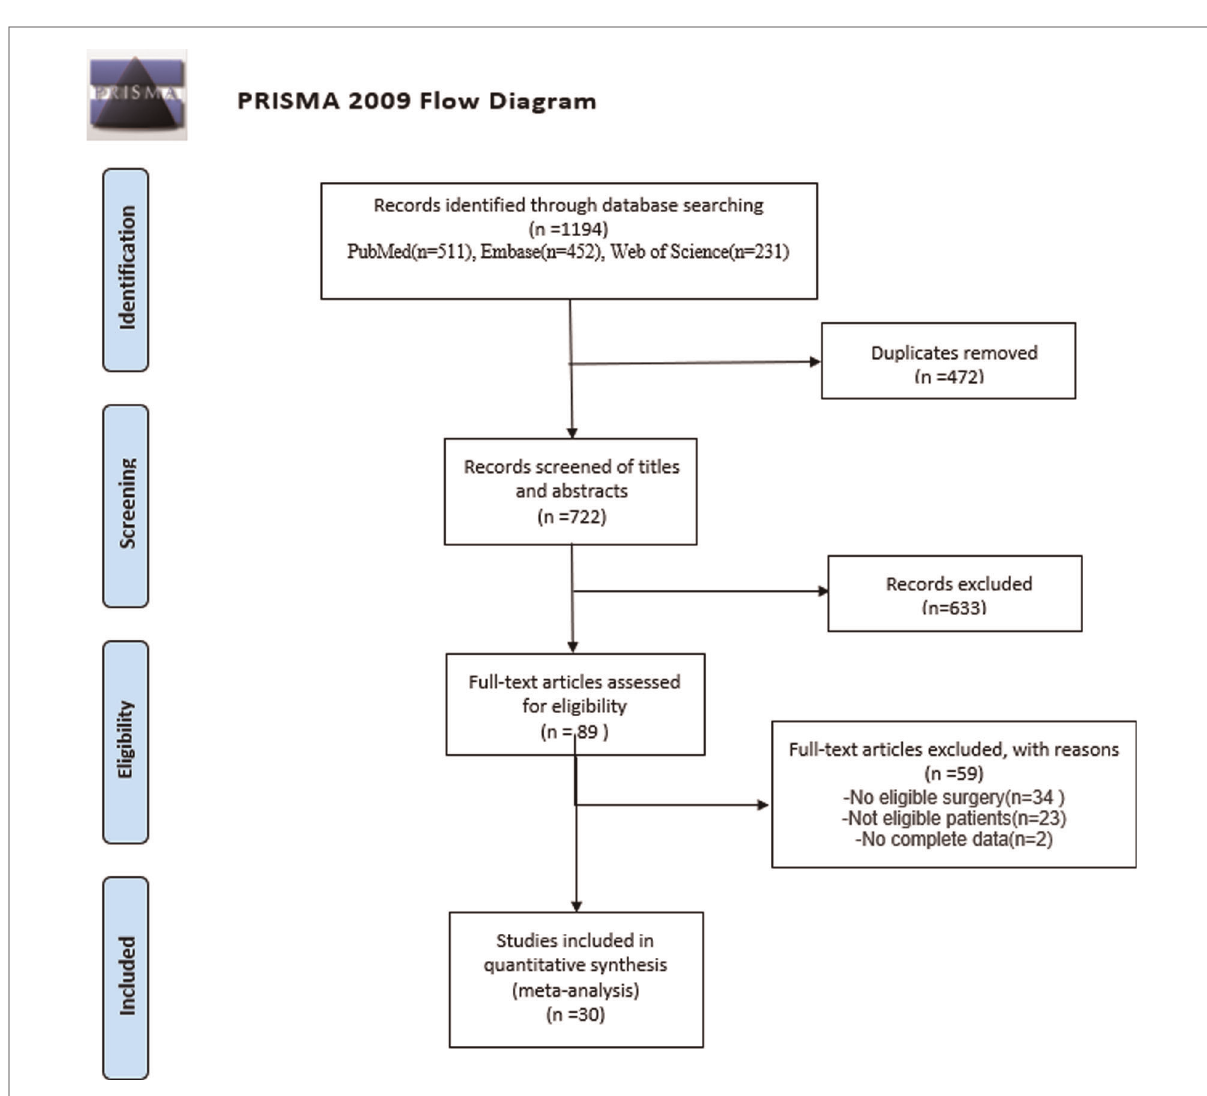
FIGURE 1 Flow diagram illustrating number of studies evaluated at each stage in the